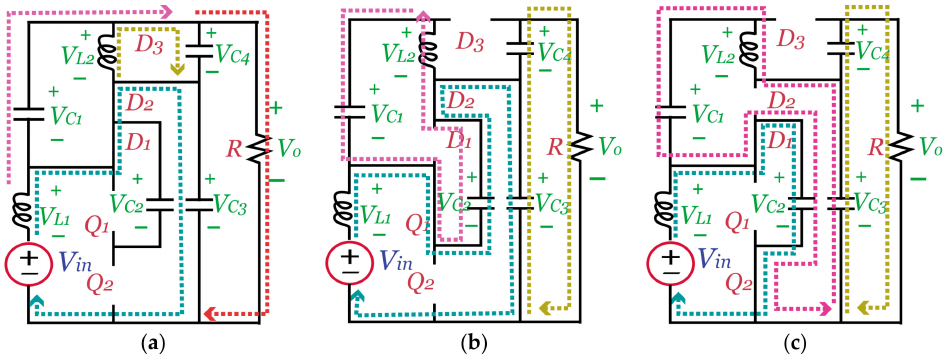
Figure 3. Current flow paths when D < 0.5. ( a ) S 1 S 2 = 00. ( b ) S 1 S 2 = 10. ( c ) S 1 S 2 =